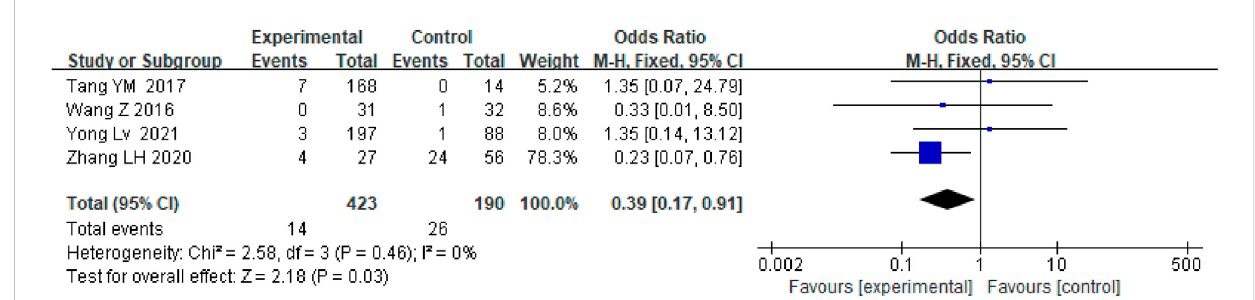
FIGURE 9 Effect of anticoagulation or antiplatelet treatment on new portal vein thrombosis after TIPS.